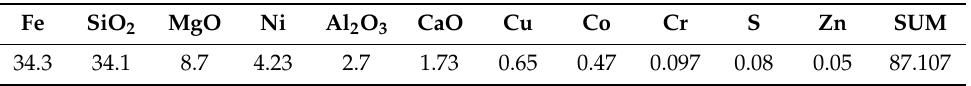
Table 1. Compositions of the Direct Outotec Nickel technology (DON) slag (sample S0) in wt% measured with XRF.